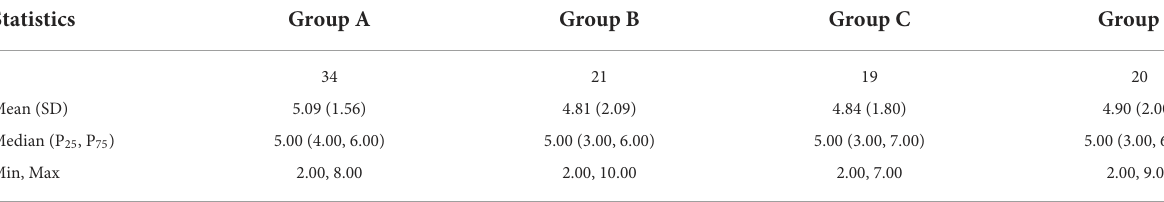
TABLE 3 Comparison of VAS scores between groups before treatment.